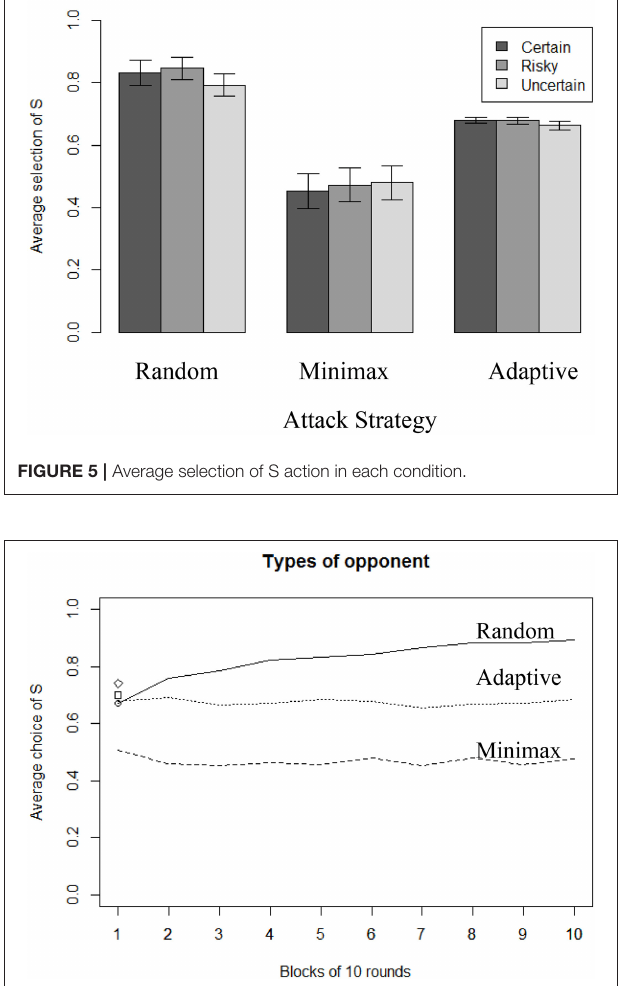
TABLE 3 | Factorial analysis of variance for switching behavior over blocks of 10